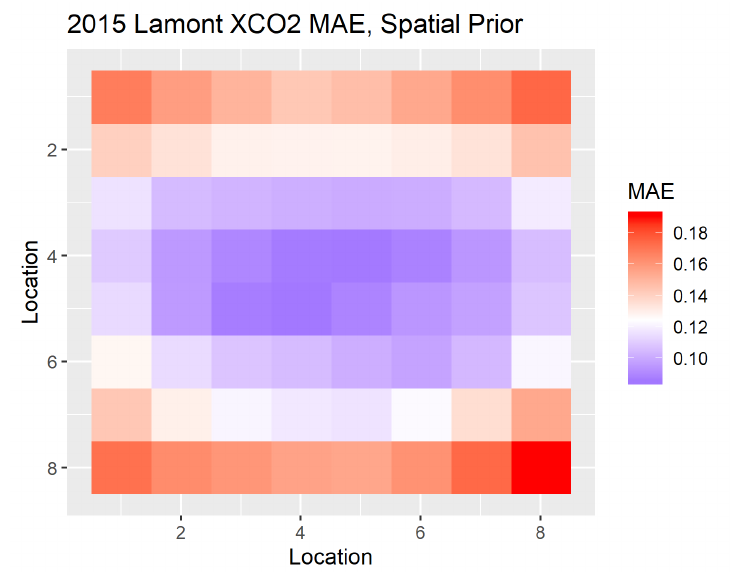
Figure 7. Mean absolute error (MAE) for XCO October 2015 Lamont template for retrievals using the spatial